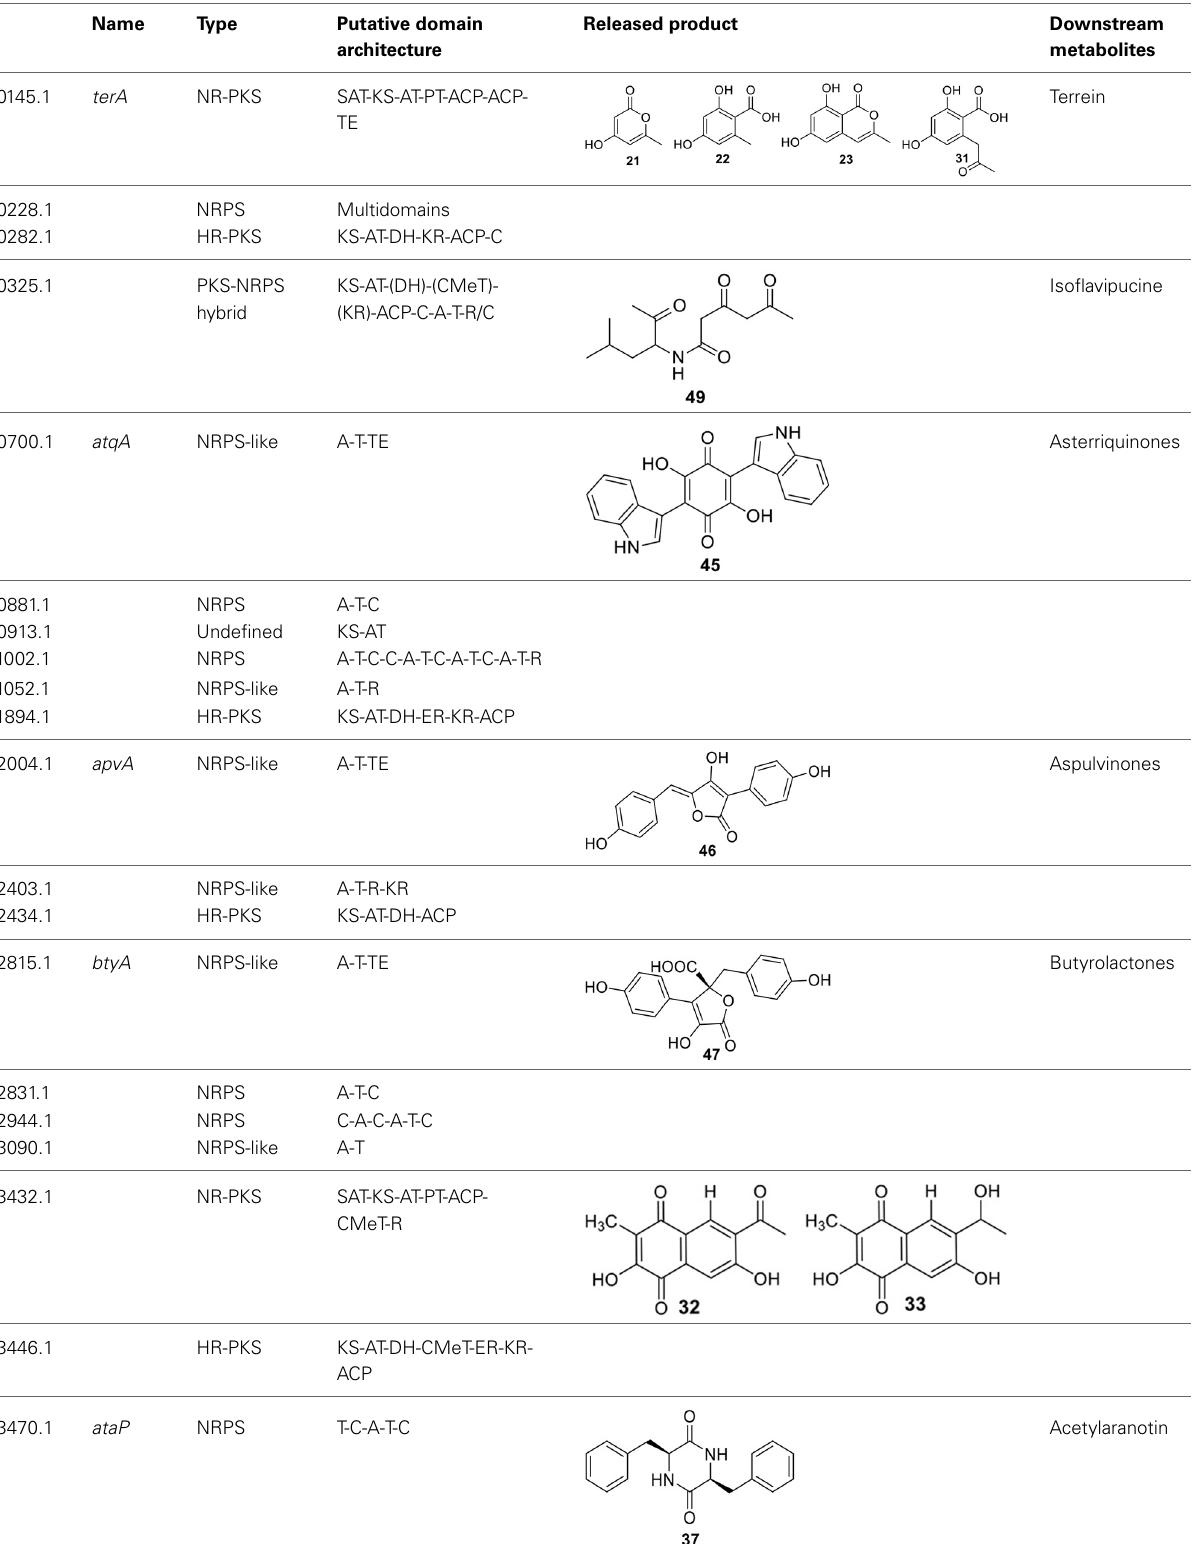
Table 1 | The core synthesis genes and their products identified in A. terreus .